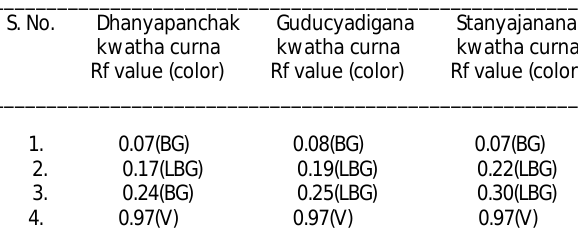
Table 3. Data of TLC study of kwatha curnas ________________________________________________________ S.